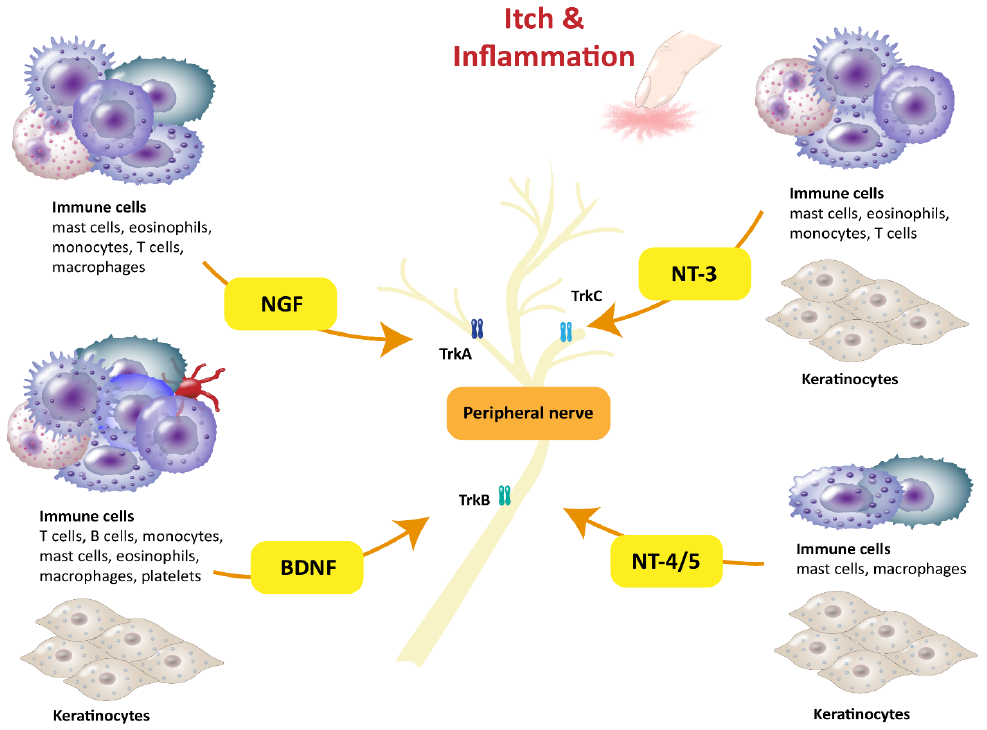
Figure 1. Immune cells release neurotrophins that affect peripheral nerves in the skin.